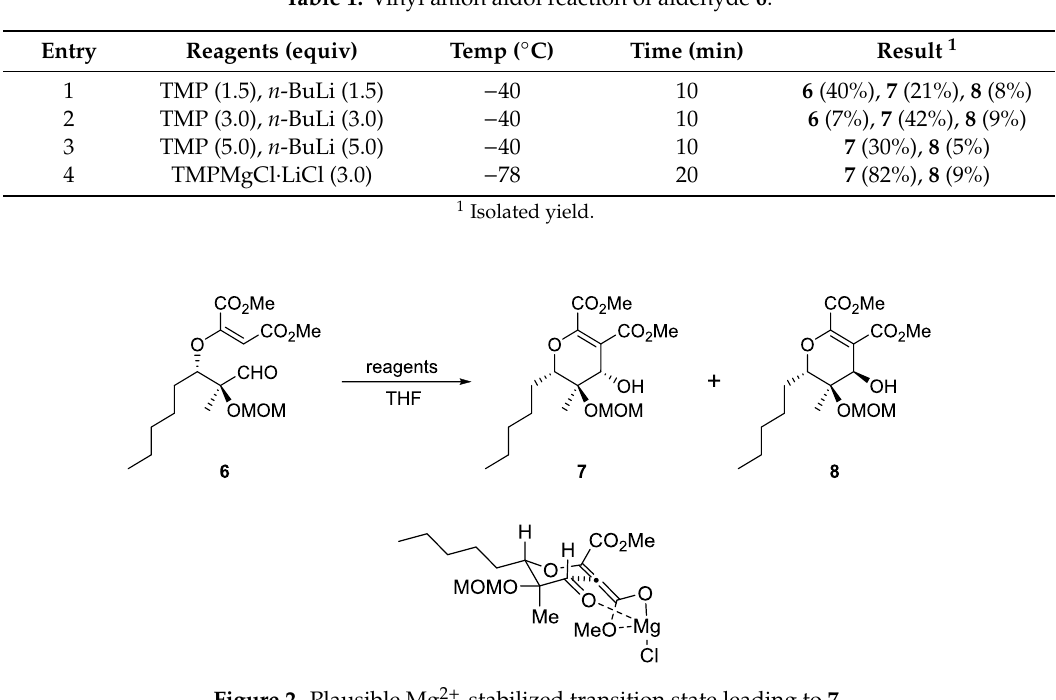
Figure 2. Plausible Mg 2+ -stabilized transition state leading to 7 .